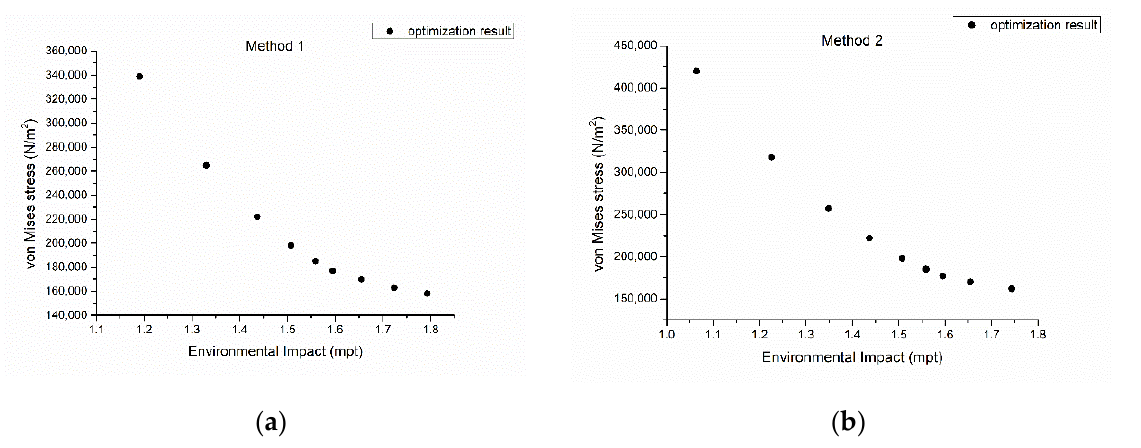
Figure 6. Multi-disciplinary and multi-objective optimization results based on ( a ) Method 1 and ( b ) Method